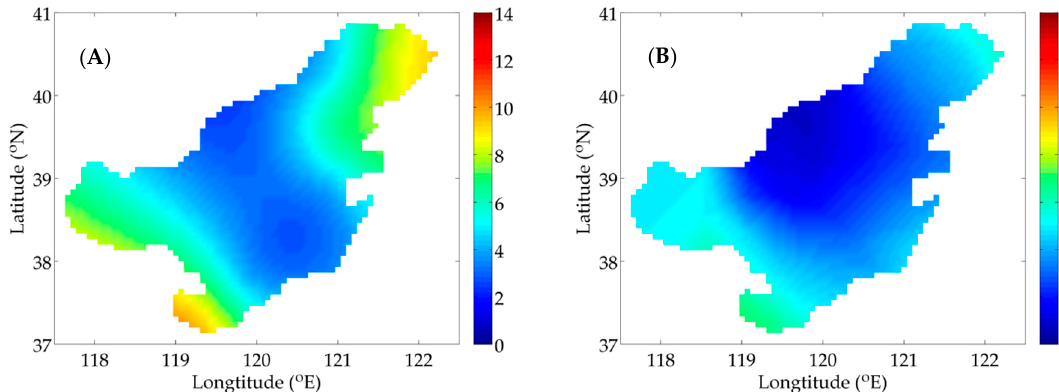
Figure 6. Distributions of P inverted with the adjoint method combined with SI ( A ); and CI ( B ) in practical experiment (unit: mmol N m − 3 ).